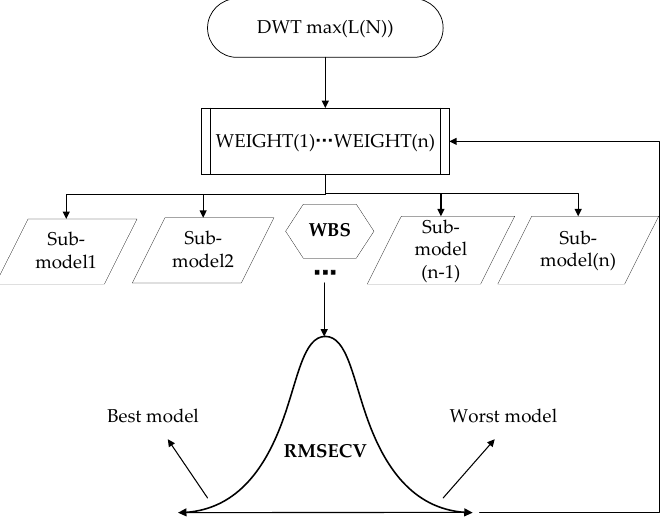
Figure 2. The flow chart of the discrete wavelet transforms (DWT) with the bootstrap soft shrinkage algorithm (BOSS) coupling algorithm. Note: N, the max layer of the DWT; WEIGHT ( n ), the weight of the n variable; WBS, weighted bootstrap sampling; sub-model, generate random combination variables and sub-model; RMSEC, sub-models’ root mean square error of cross-validation.